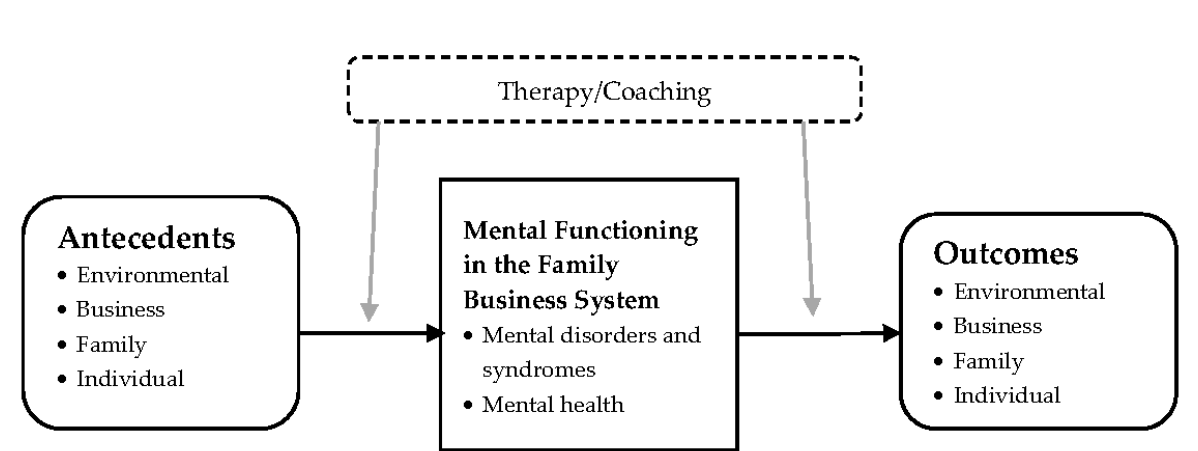
Figure 2. Mental health issues researched in family businesses and business families. (Note. Family Business System = Family, Business, Individual.). Table 1. Overview of extant research on mental health in family businesses and business families .